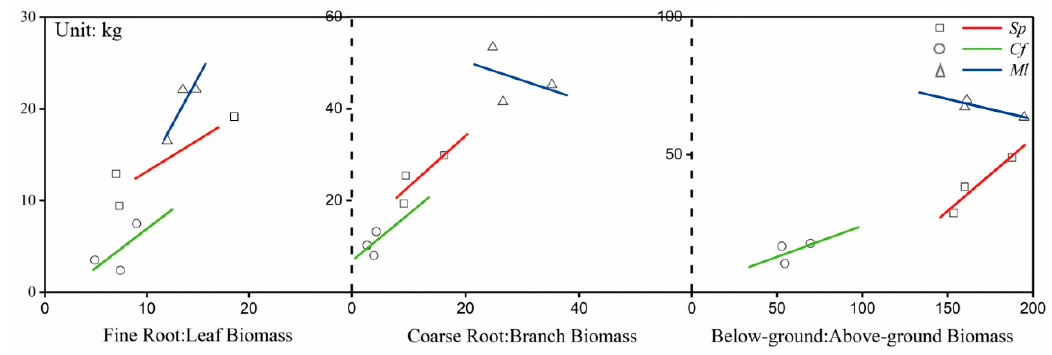
Figure 5. Three types of root:shoot ratio: fine root:leaf biomass ratio, coarse root:branch biomass ratio and below-ground:above-ground biomass ratio. Squares, circles and triangles represent trees of Sp , Cf and Ml and red, green and blue lines are the fitting regressions, respectively.